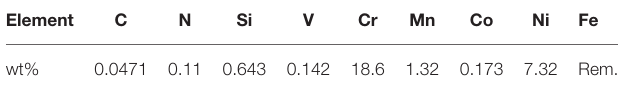
TABLE 1 | Chemical analysis of substrate.